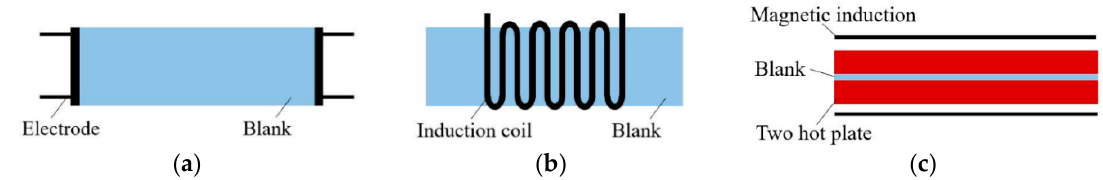
Figure 2. Advanced heating systems for hot stamping: ( a ) Resistance heating; ( b ) Induction heating; ( c ) Direct contact heating.